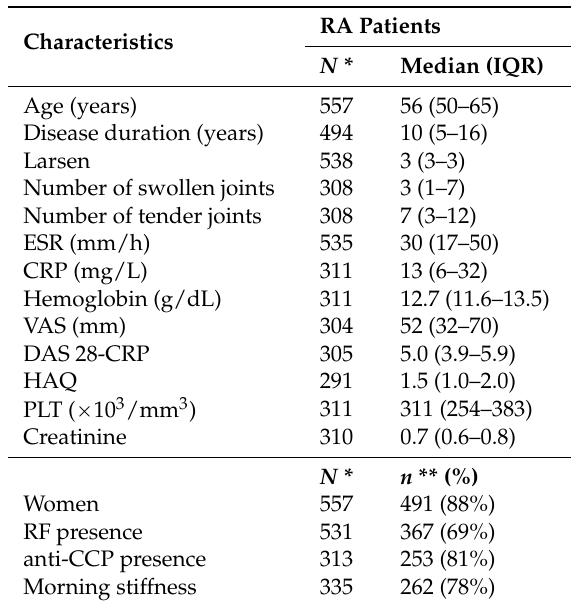
Table 8. Demographic and clinical characteristics of rheumatoid arthritis (RA)